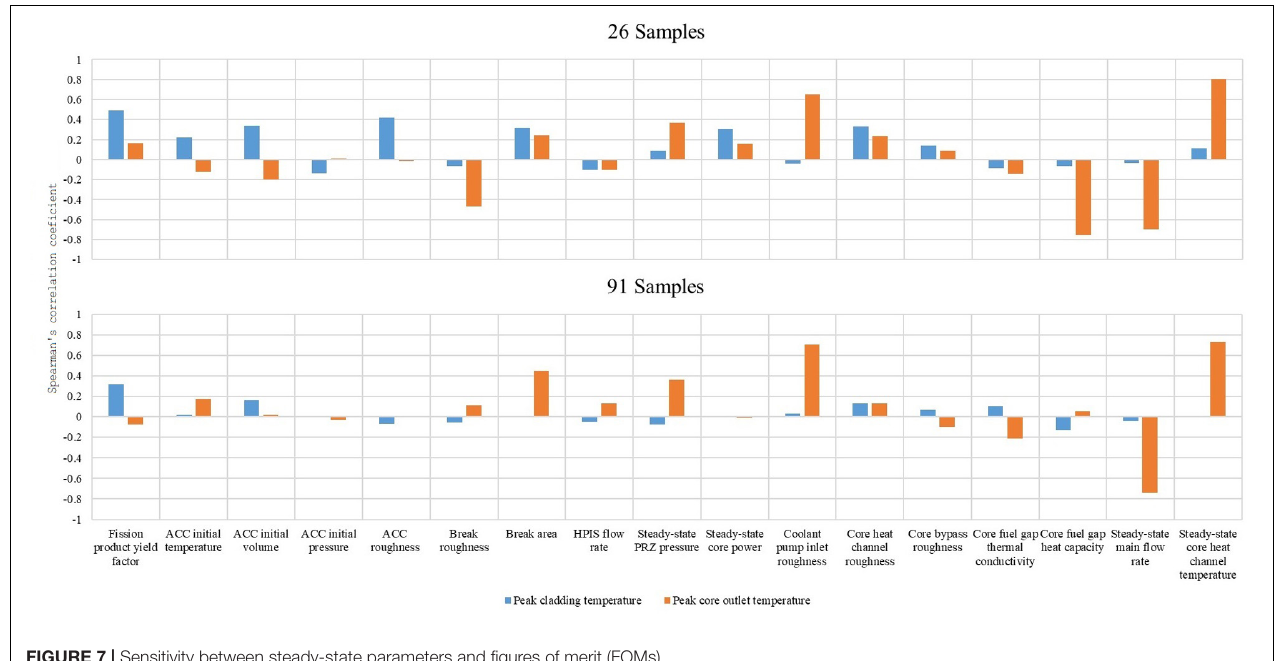
FIGURE 7 | Sensitivity between steady-state parameters and figures of merit (FOMs).